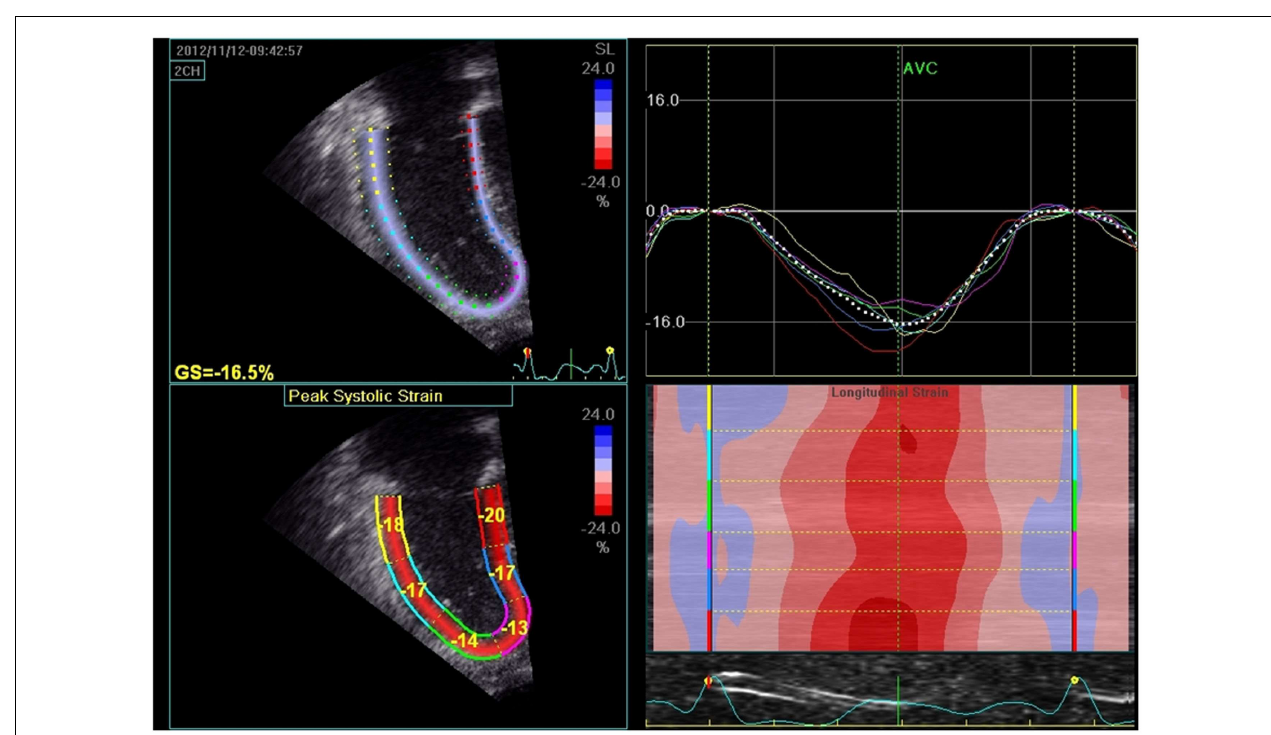
lower left panel measures the peak systolic strain in each of the myocardial segments.The lower right panel depicts the longitudinal strain according to the color map of M-mode; red segments indicate higher